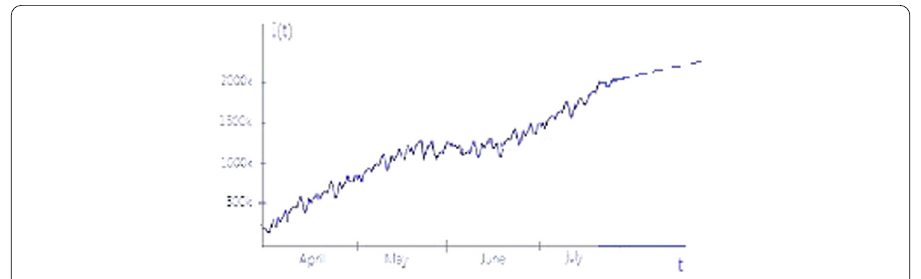
Figure 3 The sketch of Infected class of